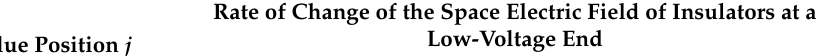
Table 4. The rate of change in the field strength of the low-voltage end space when 1 zero-value insulator was